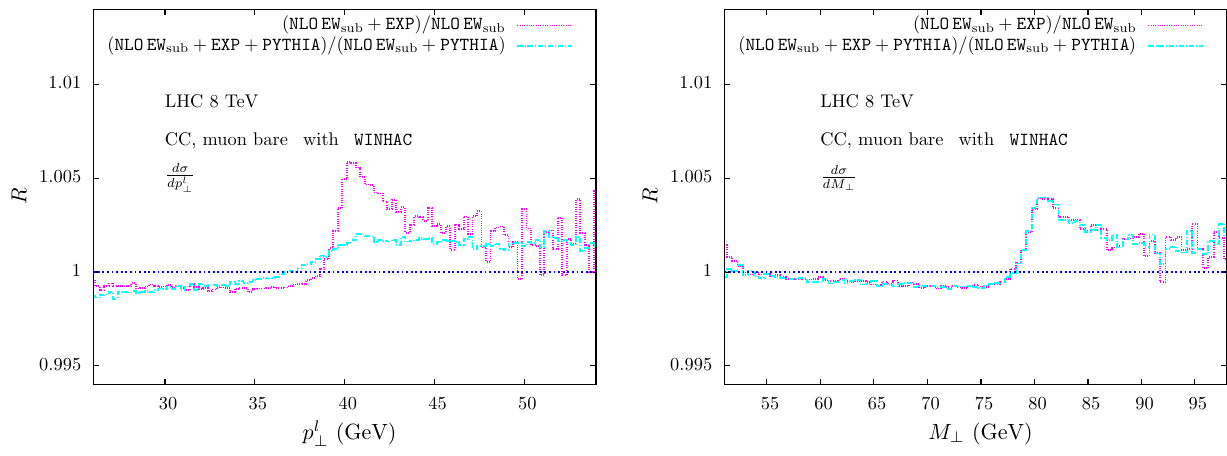
Fig. 32 Relativeeffectofhigher-order( O (α 2 ) andhigher)EWcorrec- tions in pp → μ + ν μ + X due to multiple-photon radiation in the YFS exponentiation scheme (denoted as EXP ) matched to the NLOEW sub result, expressed in units of the pure NLOEW sub calculation evaluated in the benchmark setup for bare muons, with and without taking into